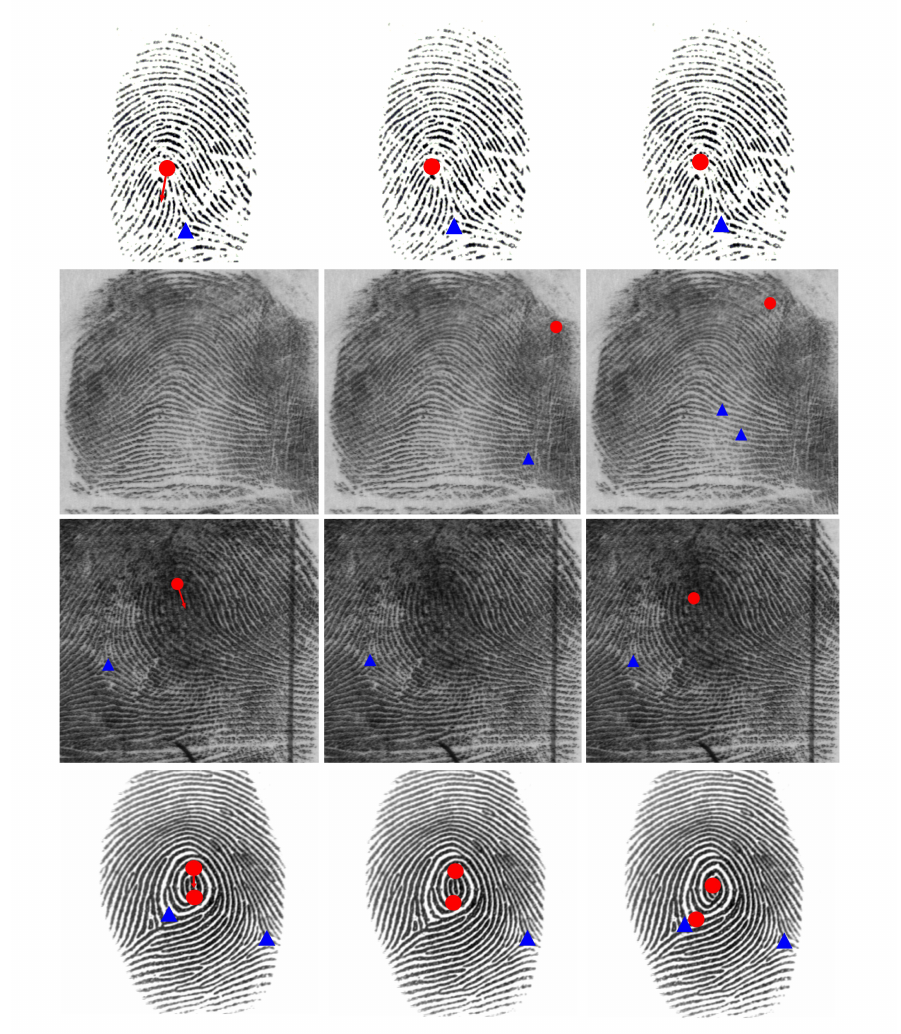
Figure 5. Illustrations of singular points detection over our method, the method of Fan et al. [7], the method of Qin et al. [17] from left to right. Red dots and blue triangles denote the core points and delta points respectively, while the red arrows represent the orientations of up-core